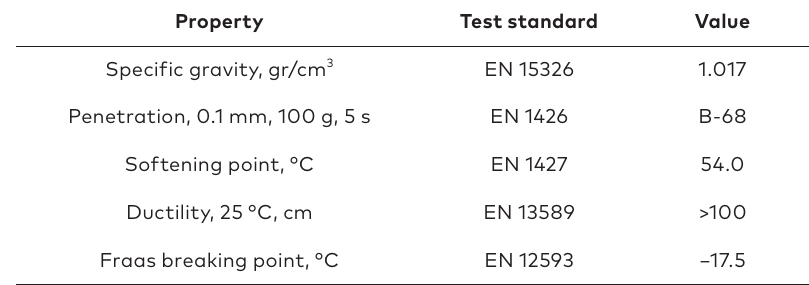
Table 3. Properties of the SBS-modified